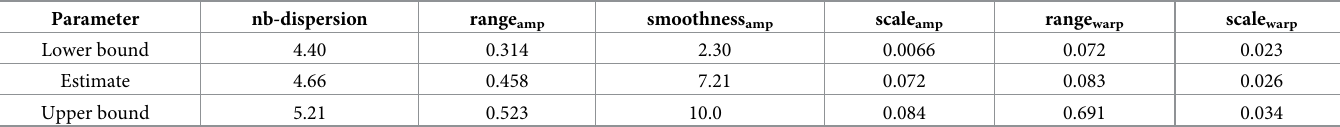
Table 4. Parameter estimates and leave-one-out results. Note: An upper bound of 10 for the Mate´rn-smoothness was used in the analysis.